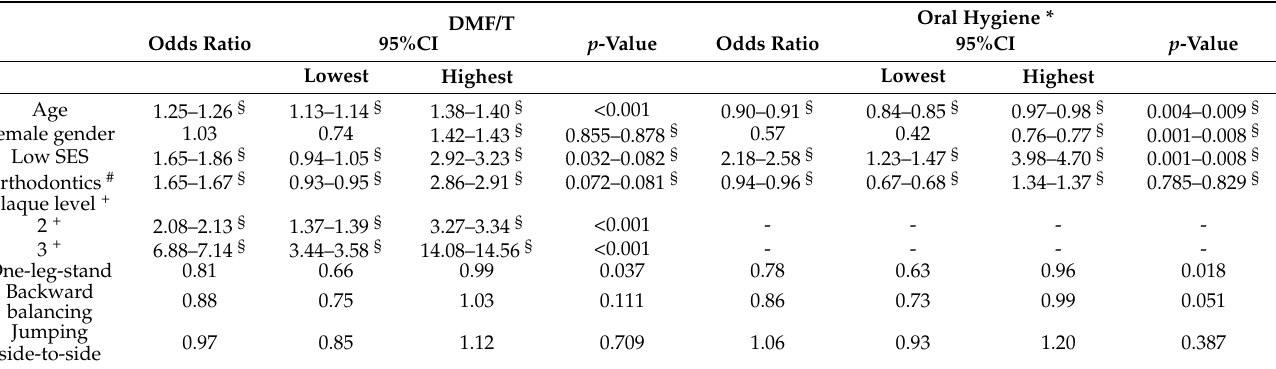
Table 3. Logistic regression analysis of dental caries experience (DMF/T)/Oral hygiene and SES, sex, age, orthodontic treatment and coordination skills in children and adolescents of 10 to 18 years (Leipzig,